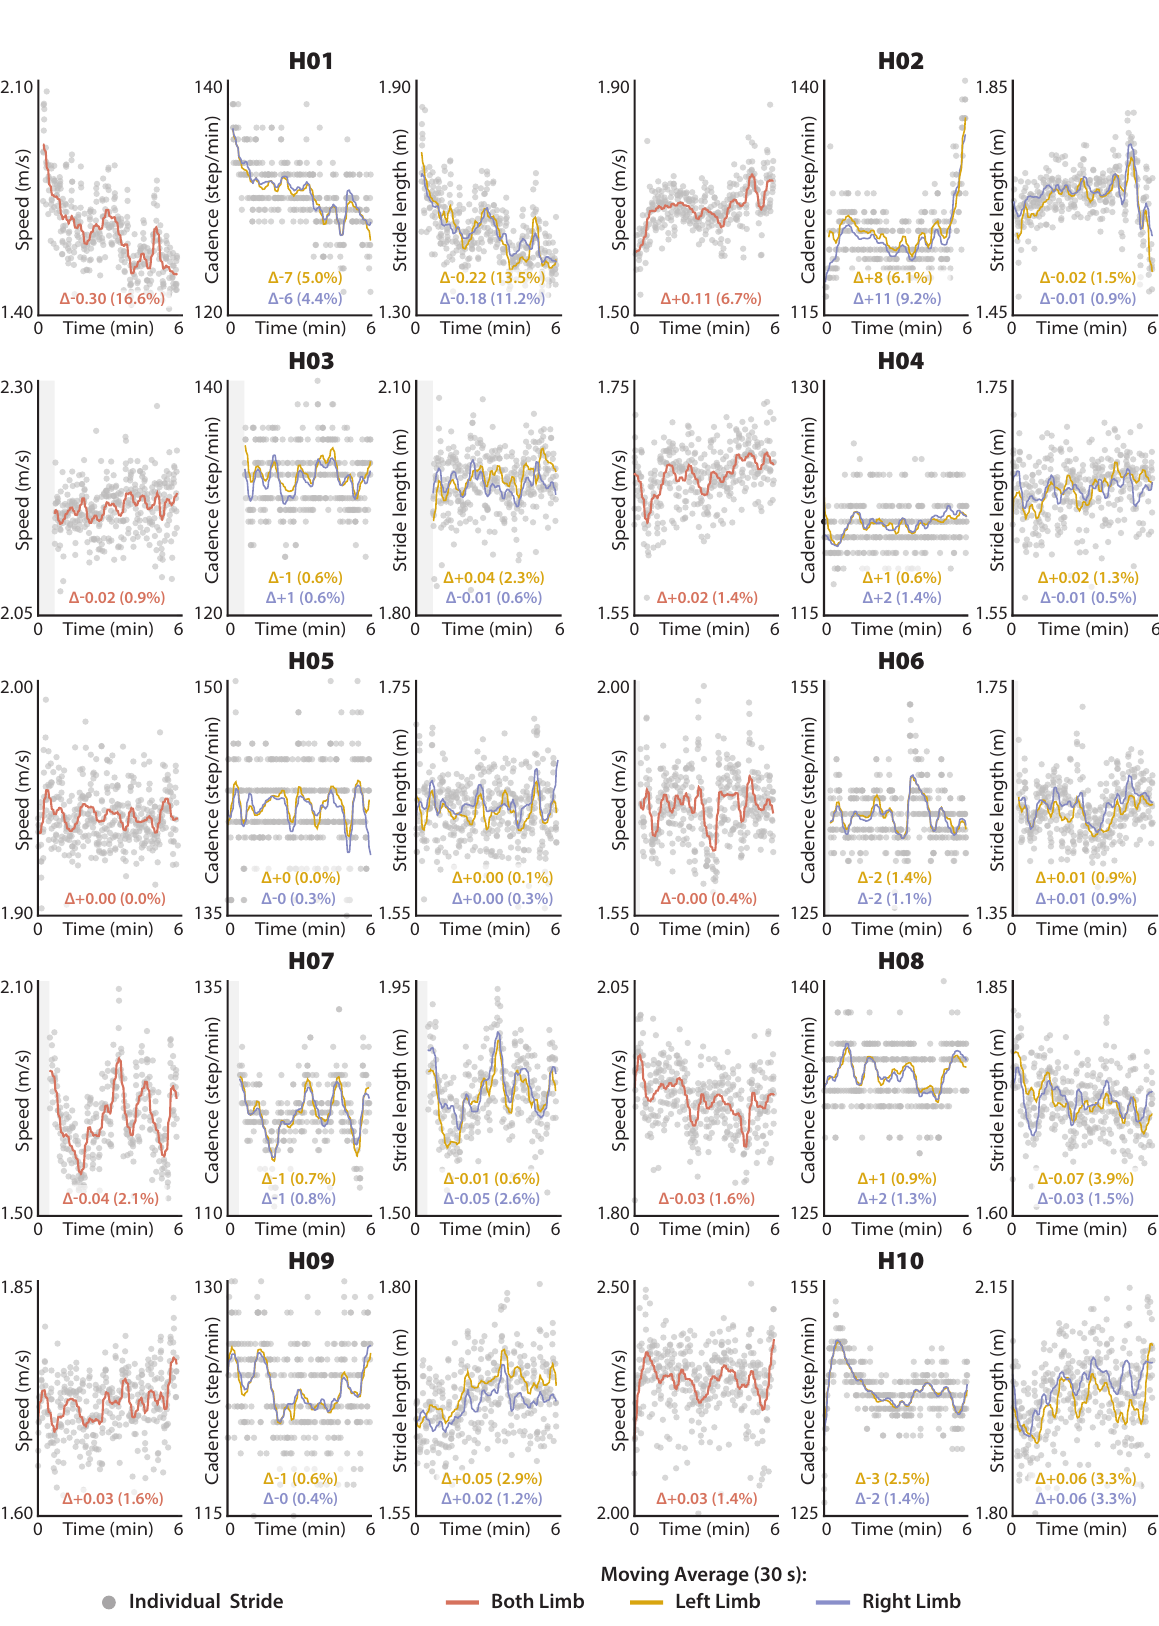
Figure 3. Distance-induced changes in speed, stride length, and cadence in healthy individuals. Reported ∆ s are the difference in the average from the last 30 s of walking and the first 30 s of walking. Regions highlighted in gray are missing